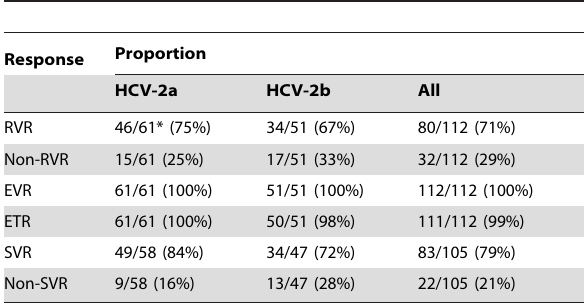
Table 1. Proportions of various virological responses of HCV- 2a- and HCV-2b-infected patients treated with PEG-IFN/RBV.